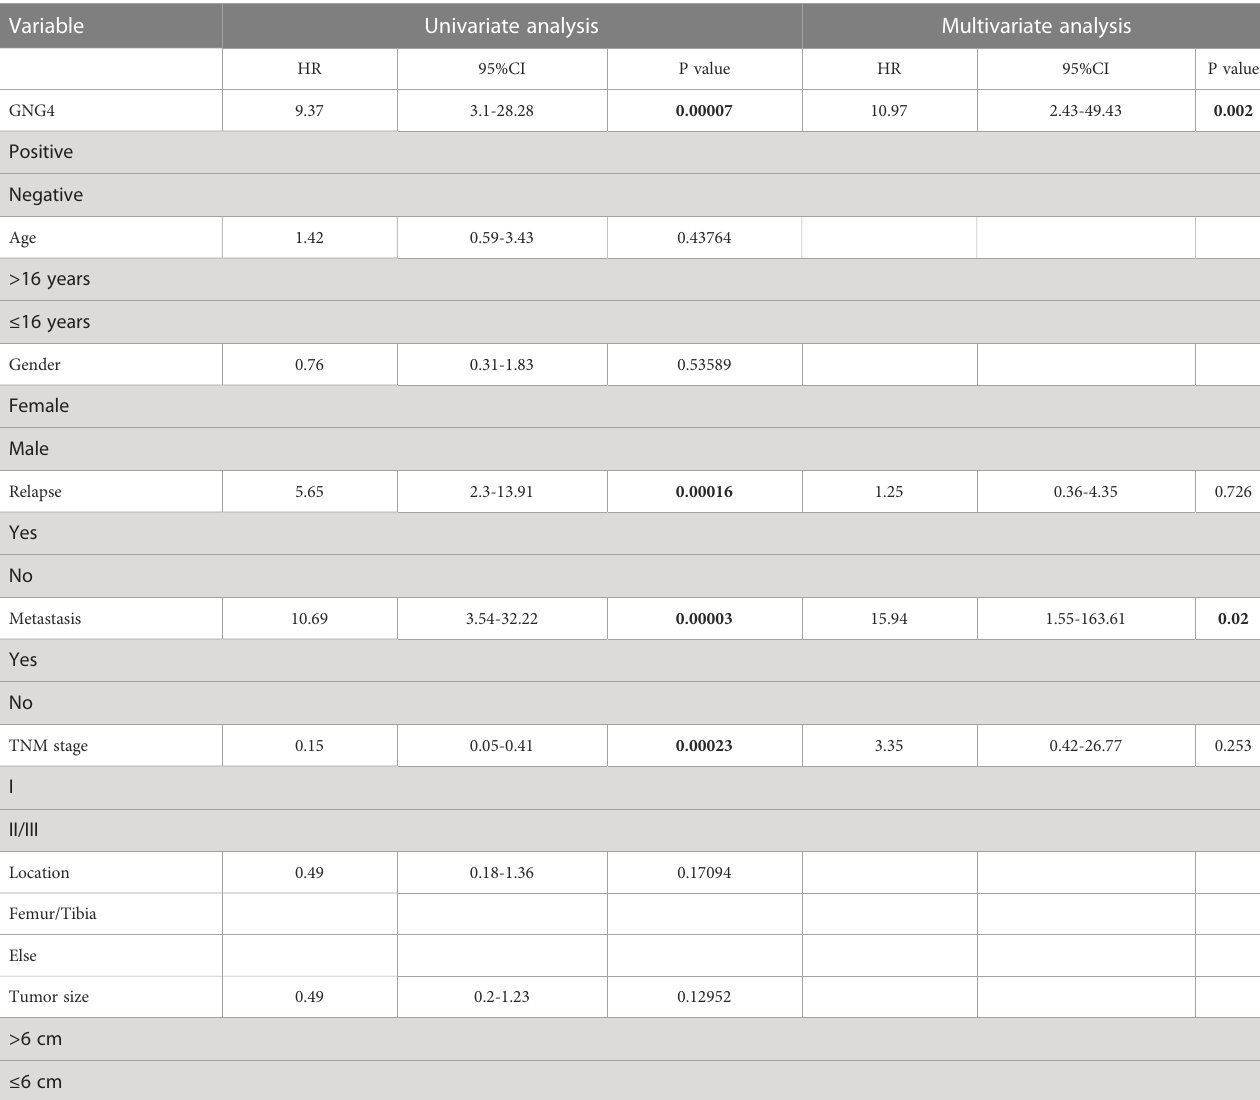
TABLE 4 Univariable and multivariable Cox regression analysis of clinical characteristics and GNG4 in the external validation cohort.